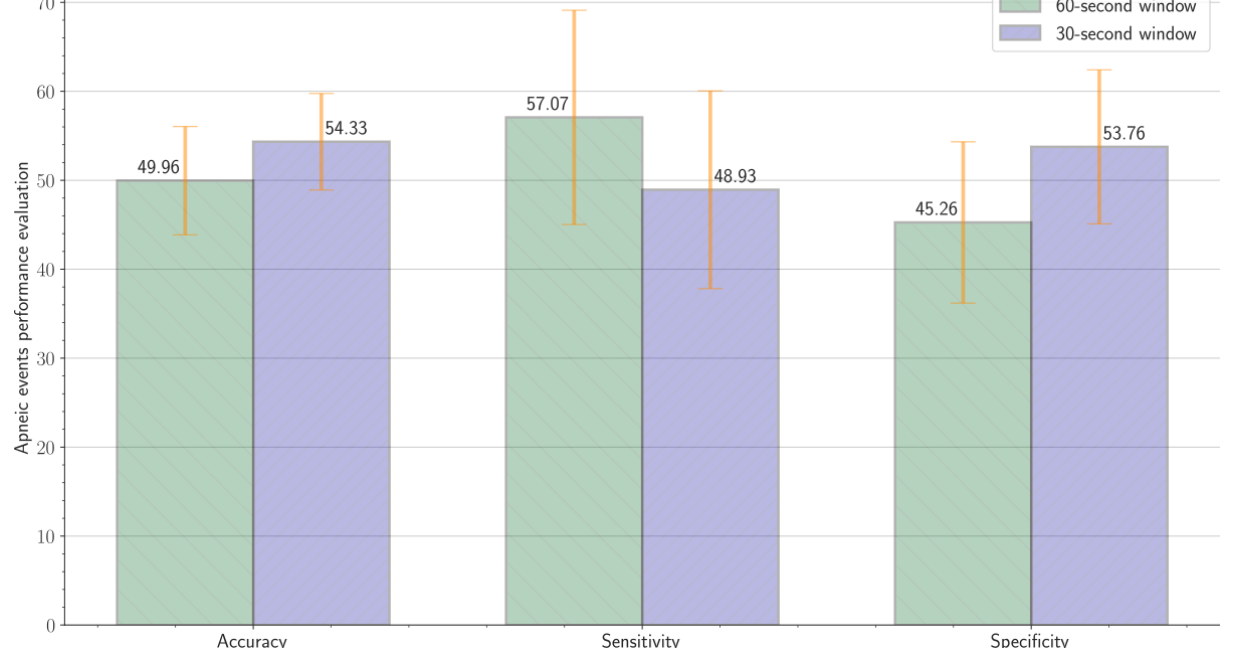
Figure 13. Bar charts with error bars for accuracy, sensitivity, and specificity regarding apneic events detection (60-second and 30-second time windows). The bars represent the mean of each measure, and the cap-tipped lines represent the uncertainty (SD) in each